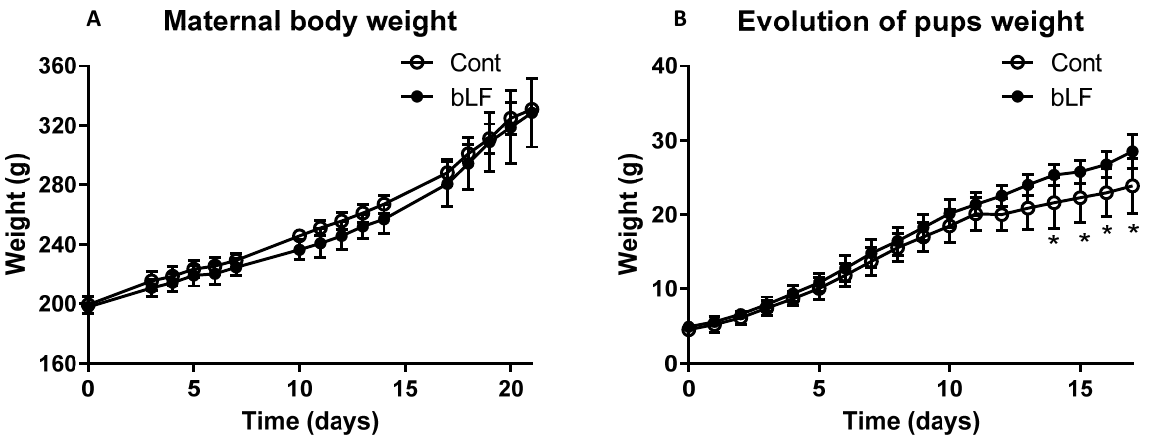
Figure 1. Effect of bLF supplementation on mother and pup body weight evolution. Maternal body weight during gestation ( A ). Pup weight evolution from birth to 17 days ( B ). Maternal bLF supplementation (bLF) or without supplementation (Cont). Data represented are means ± SEM (* p < 0.05; n = 16 pups per group). The Cont and bLF groups were compared by an unpaired two-tailed Student’s t